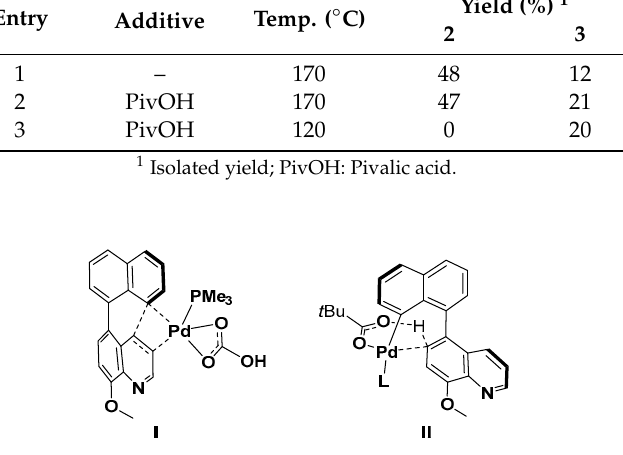
Table 1. Optimization of the reaction conditions for the synthesis of 2 and 3 .